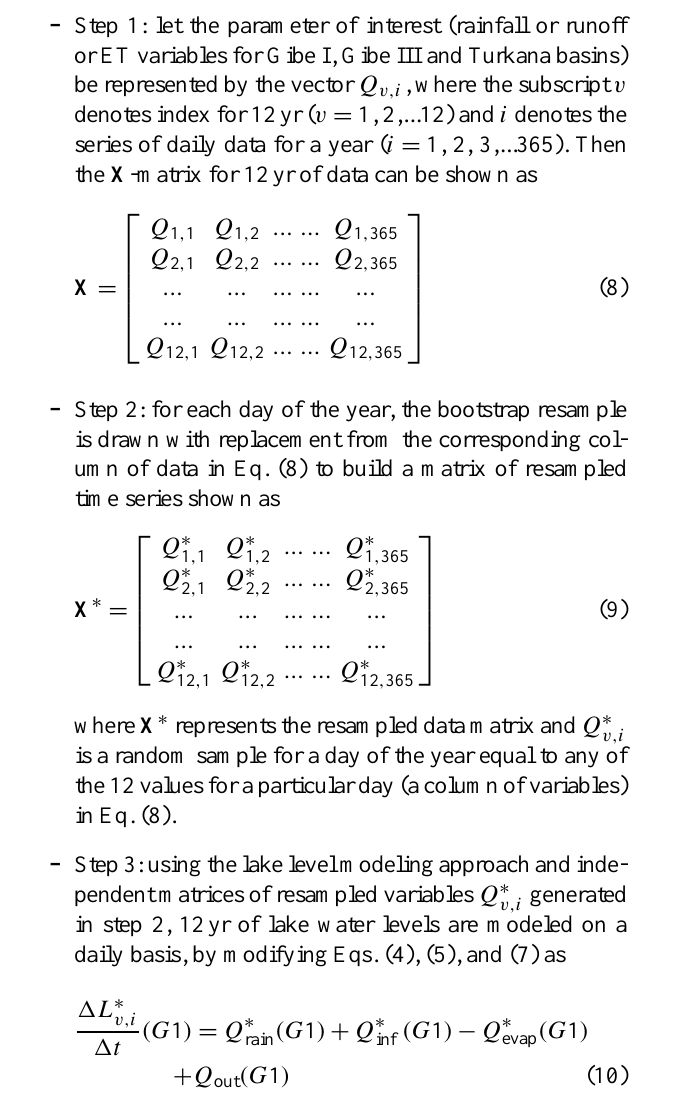
Table 2. Scenarios of rainfall generated based on the rainfall based scenarios in the East African region. Years